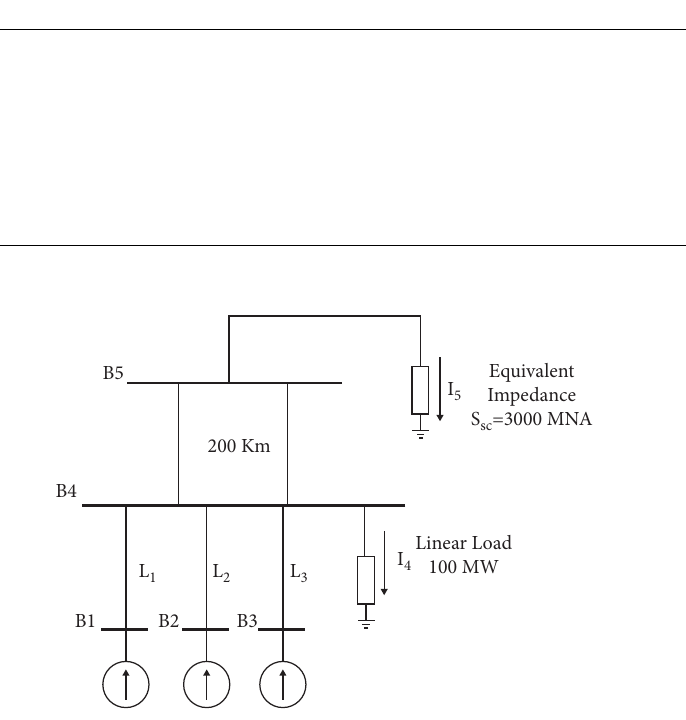
Table 1: Summation methods adopted (equations from [35]).